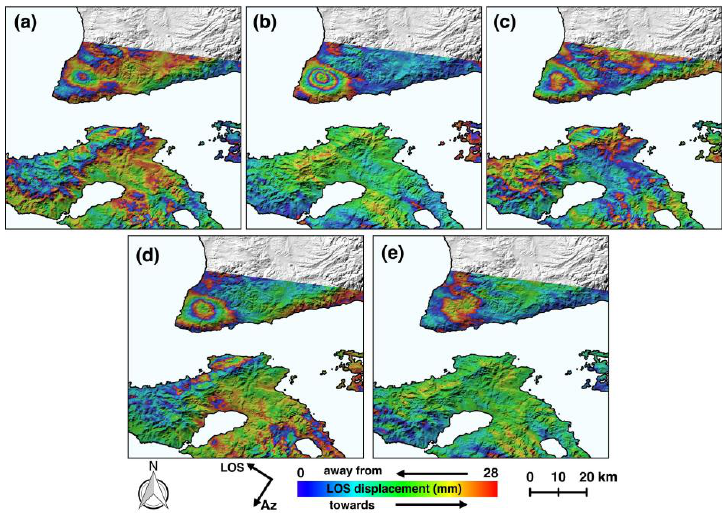
Figure 4. S1 interferograms from the descending track 36 ( a ) 20170131 – 20170206, ( b )